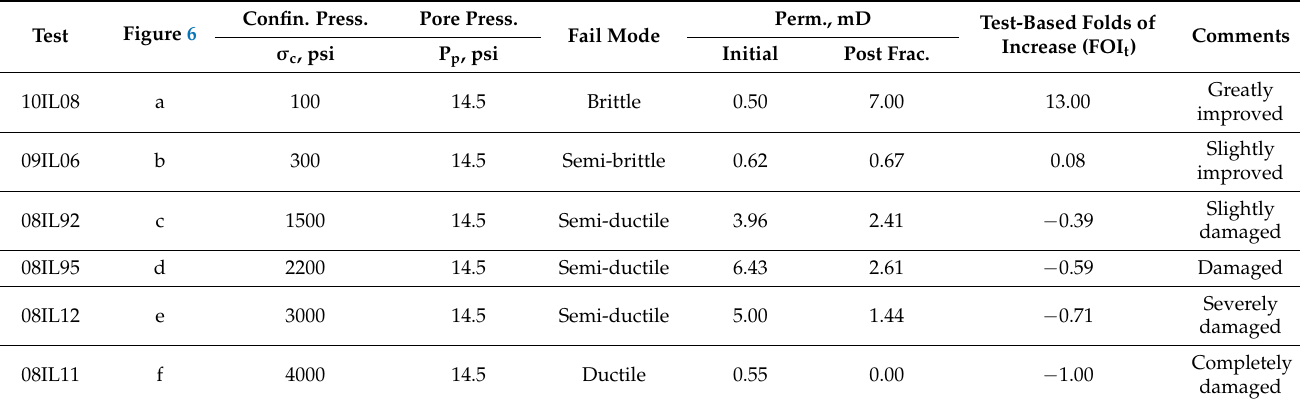
Table 2. Failure mode impact on post-frac permeability and FOI t